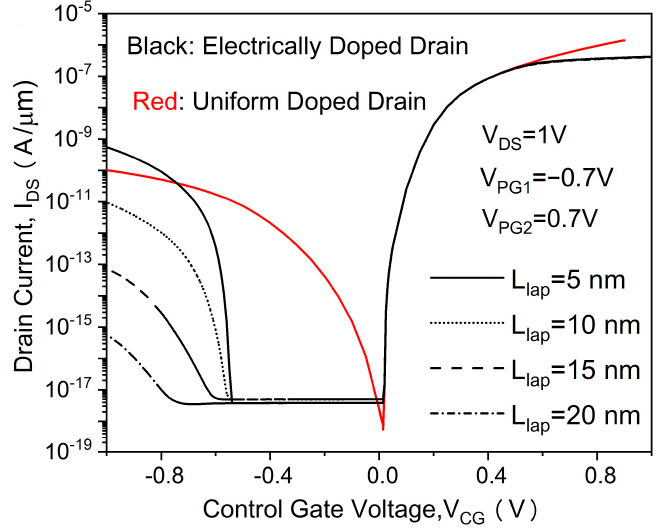
Figure 2. Transfer characteristics of proposed in-built N + pocket ED-TFET with an ED drain and conventional in-built N + pocket ED-TFET with uniformly doped drain.